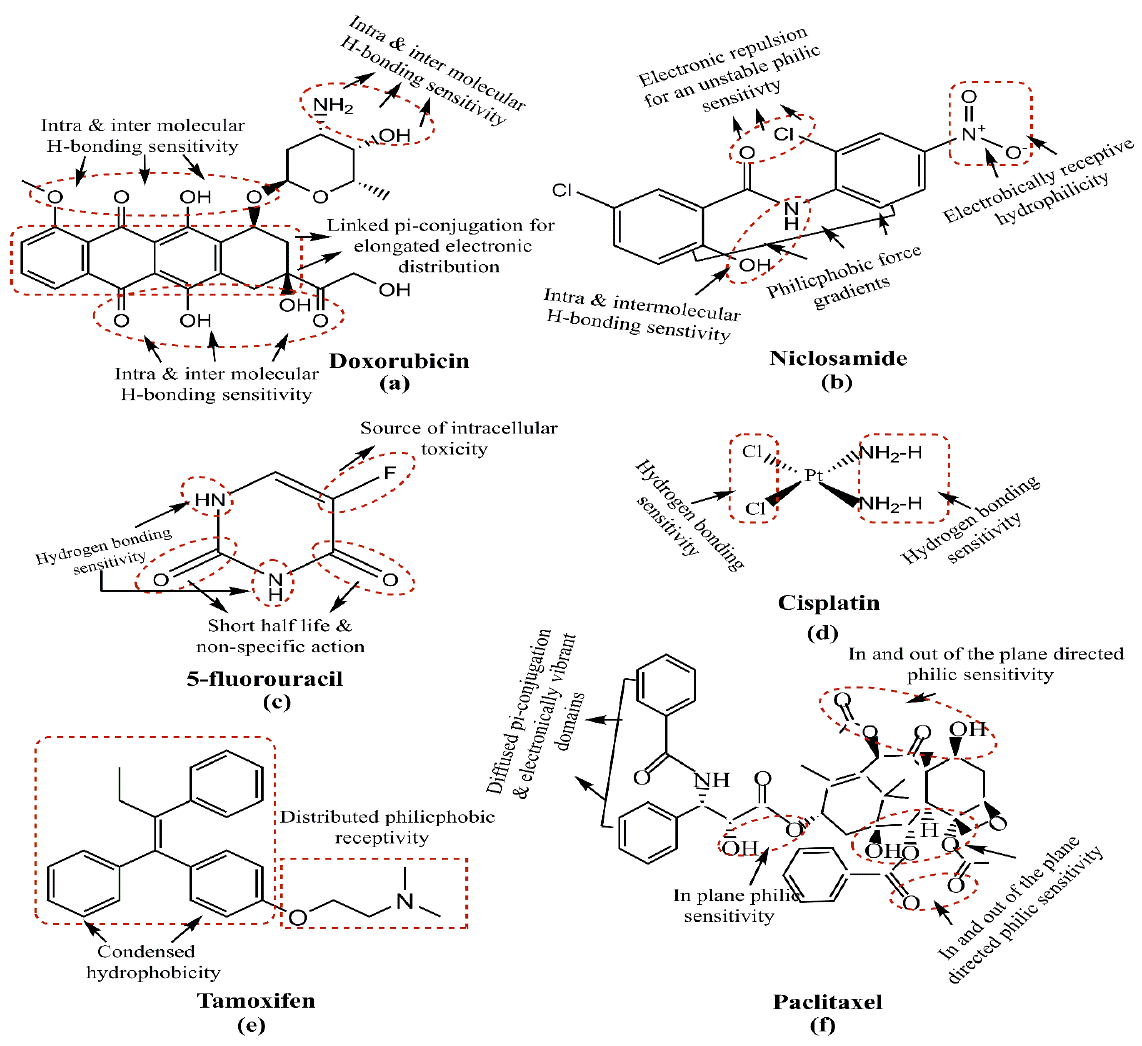
Figure 16. Structural distinctions of ( a ) doxorubicin, ( b ) niclosamide, ( c ) 5-fluorouracil, ( d ) cisplatin, ( e ) tamoxifen and ( f ) paclitaxel. The high toxicity of doxorubicin, cisplatin, 5-fluorouracil and paclitaxel concur with a need for their nanocarrier-mediated delivery. Alternatively, co-delivery (without nanocarriers) with natural phenols such as curcumin, hesperetin, quercetin and others (all much less toxic) could moderate the dosages of listed chemotherapeutic drugs.